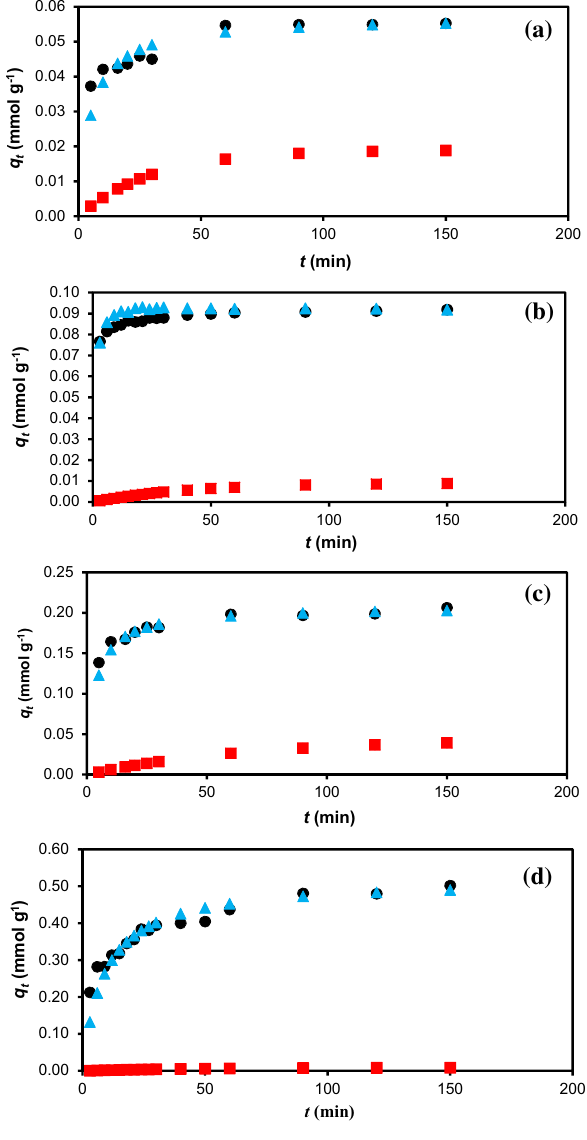
Fig. 6 Comparison of experiment data (●) with the Lagergren pseudo-first-order kinetics ( ) and pseudo-second-order (